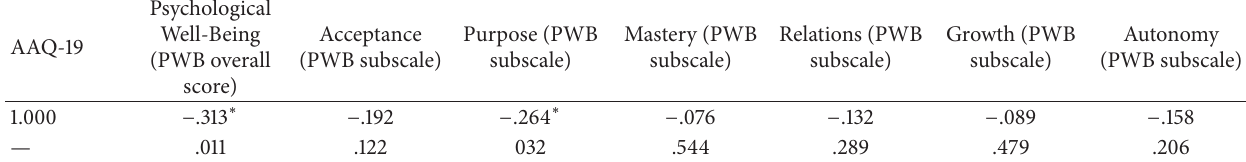
Table 2: Correlations between the AAQ-19 and the Scales of Psychological Well-Being (PWB) and its subscales.